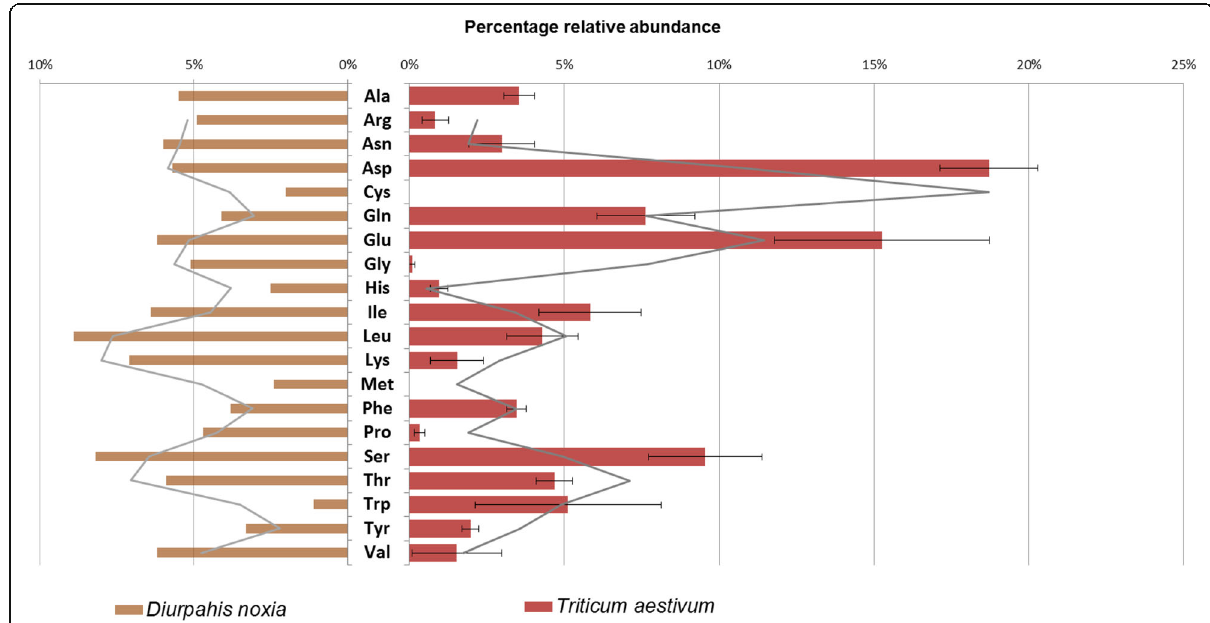
Fig. 4 Amino acid content comparison of Diuraphis noxia proteins and wheat phloem. Bar plots indicate relative abundance of amino acids in Triticum aestivum subsp. aestivum L ( red ) and as component of protein coding genes within Diuraphis noxia ( brown ) along with two-point moving average lines